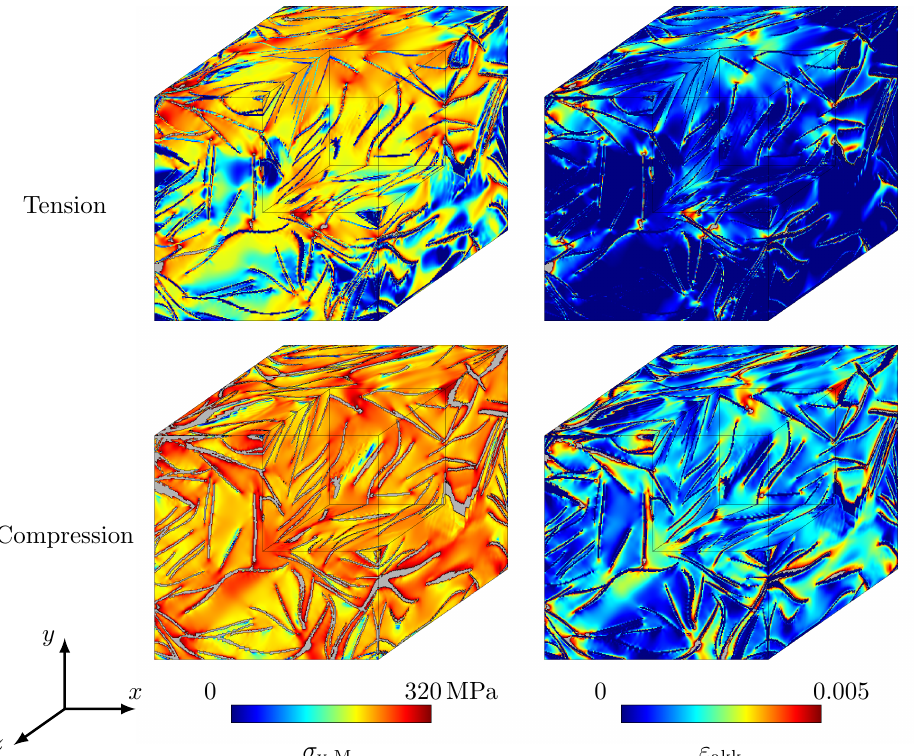
Figure 13. Contour plots for tensile and compressive load of a statistical volume element of the class IA2, with a graphite flake volume fraction of 12v. and the accumulated plastic strain, ε akk , are shown, at a macroscopic strain of the same magnitude in the x direction of ε =